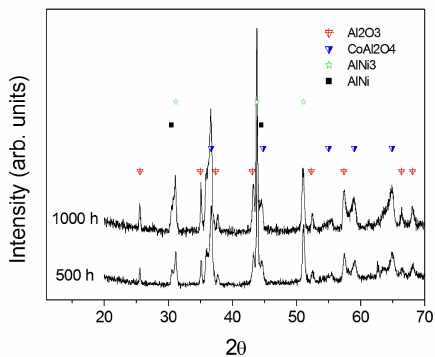
Figure 10. XRD analysis performed on HVOF sprayed CoNiCrAlY on IN738 + heat treatment at 500 and 1000 h of isothermal test.